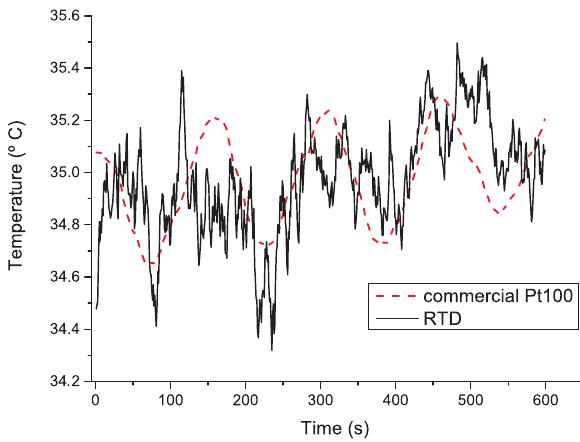
Figure 10. Measurements temperature results with a commercial Pt100 and the proposed RTD when medium is set to 35 ◦